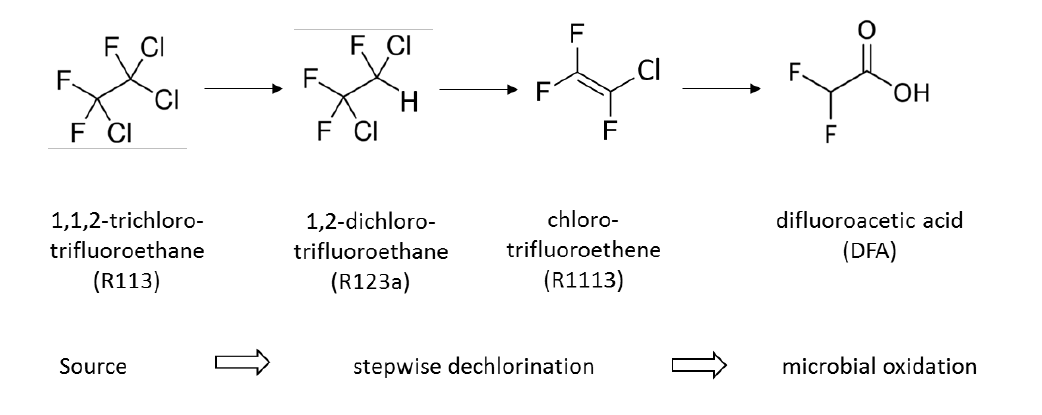
Figure 2. Reductive dechlorination of R113 to R1113 according to Balsiger et al. [15] as observed, and the proposed hydrolysis of R1113 to DFA.